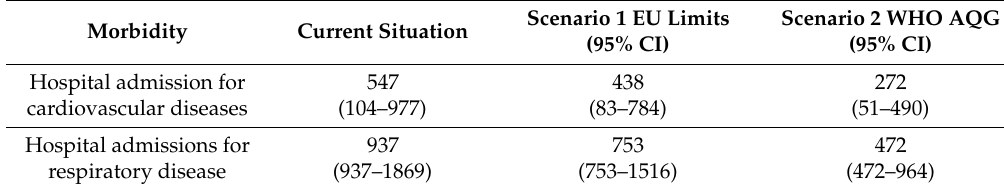
Table 4. Morbidity outcomes under different PM 2.5 scenarios in year